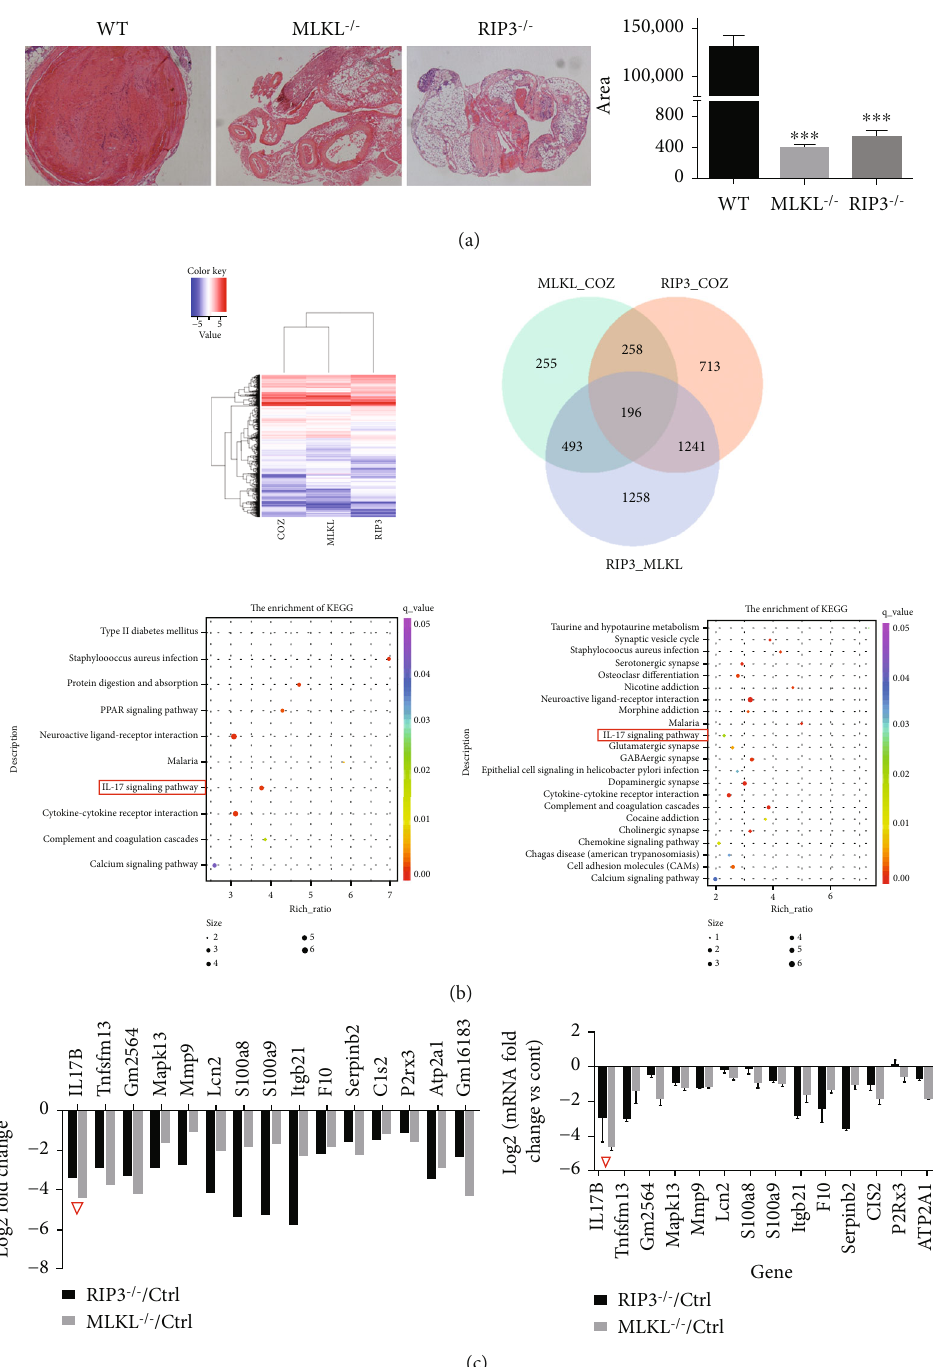
Figure 3: The activated RIP3/MLKL pathway is associated with increased IL-17B. The activated RIP3/MLKL pathway is associated with increased IL-17B. (a) H&E staining to observe thrombosis ( n = 3 , scale = 50 μ m, 100x). Cross-sectional thrombus area measured on H&E images by Image-Pro Plus 6.0. (b) The IVC tissues of DVT RIP3-/- mice, MLKL-/- mice and WT mice were sequenced using an Illumina platform. The sequencing strategy was PE150. The enriched KEGG items were analyzed between the DVT and control groups. The size of the dots represents the number of genes. The color of the dot represents the P value. (c) Q-PCR was used to verify the di ff erence RNA with consistent changes in KEGG enrichment analysis. IL-17B was most signi fi cantly down-regulated in RIP3-/- mice and MLKL-/- mice compared with the WT mice (marked by a red